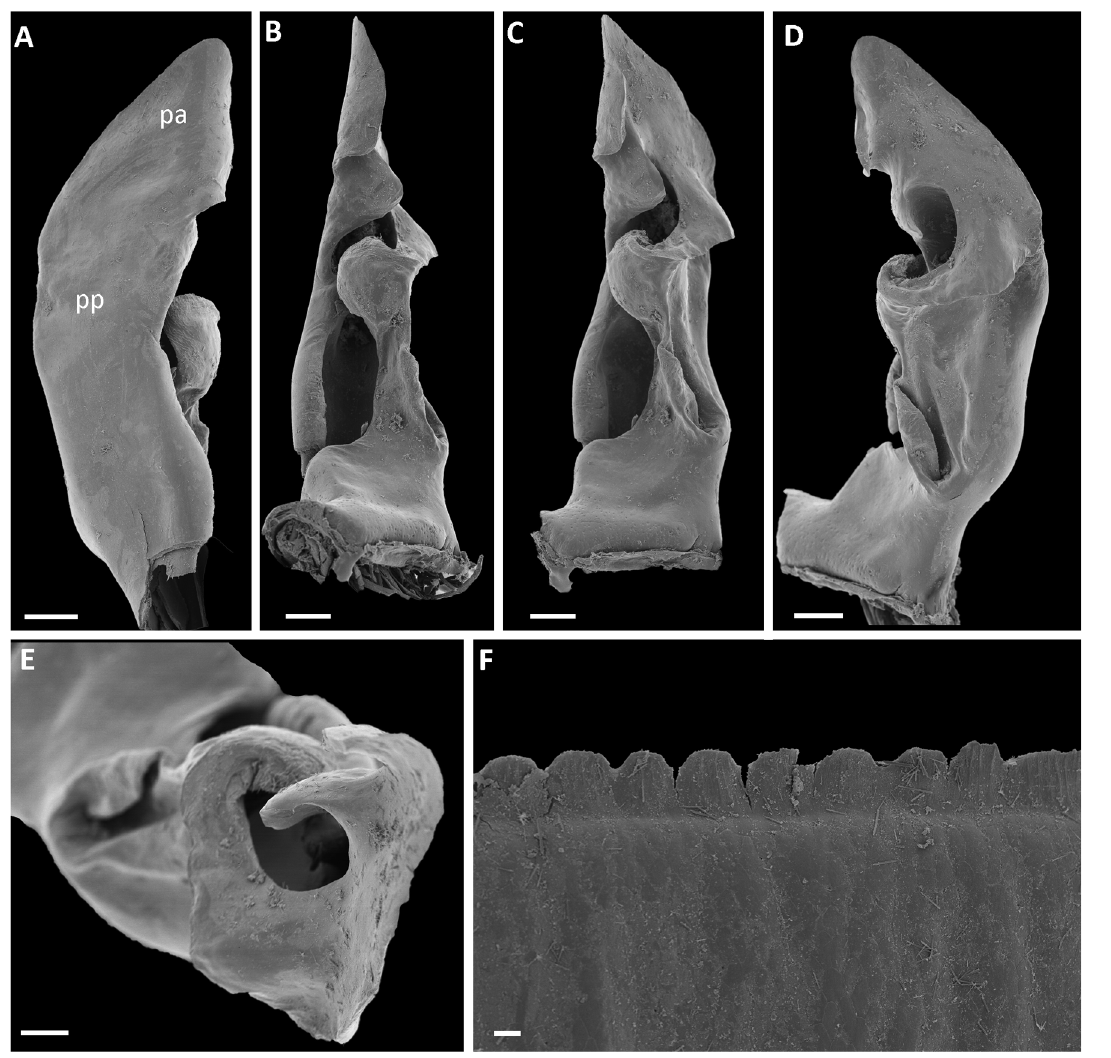
Fig. 14. Aquattuor nguruensis sp. nov., holotype, ♂ (VMNH110617). A – E . Left gonopod coxa. A . Anterior view. B . Mesal view. C . Meso-posterior view. D . Posterior view. E . Apical view. F . Midbody dorsal limbus. Abbreviations: pa = palette; pp = proplica. Scale bars: A–D = 0.1 mm; E = 0.05 mm; F = 0.01